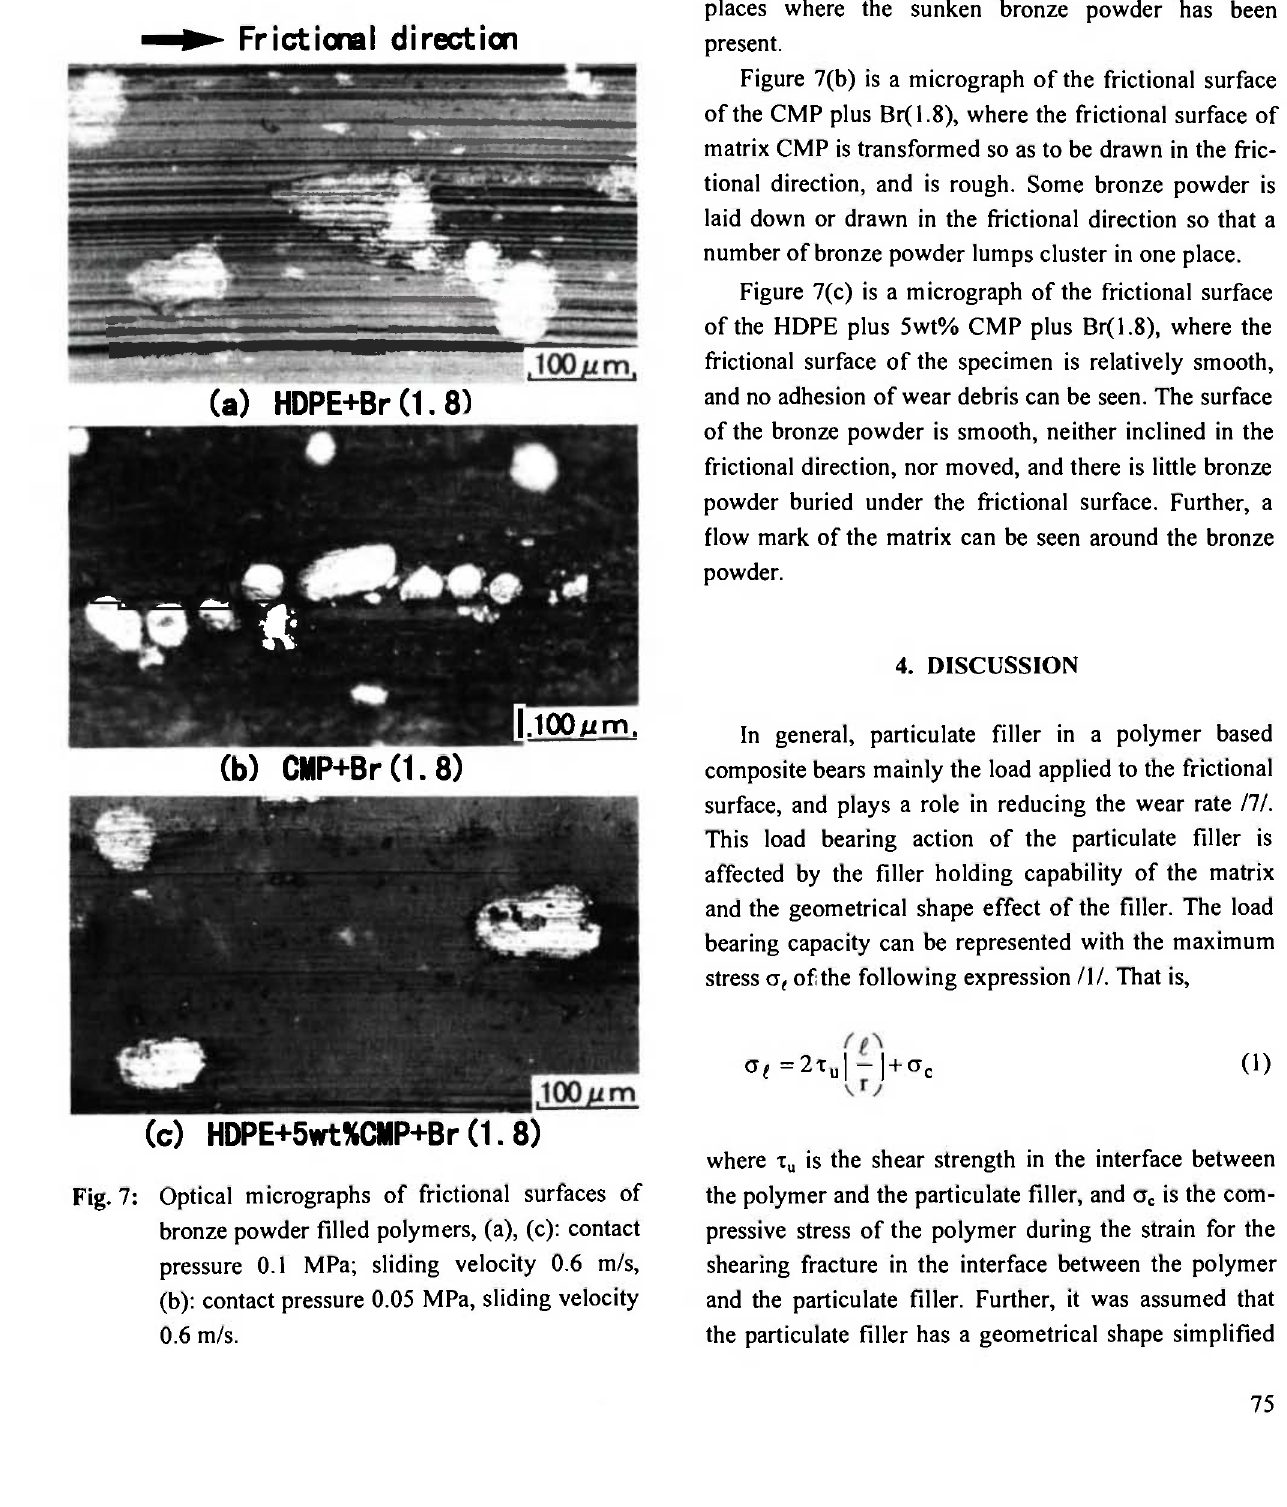
Fig. 7: Optical micrographs of frictional surfaces of bronze powder filled polymers, (a), (c): contact pressure 0.1 MPa; sliding velocity 0.6 m/s, (b): contact pressure 0.05 MPa, sliding velocity 0.6